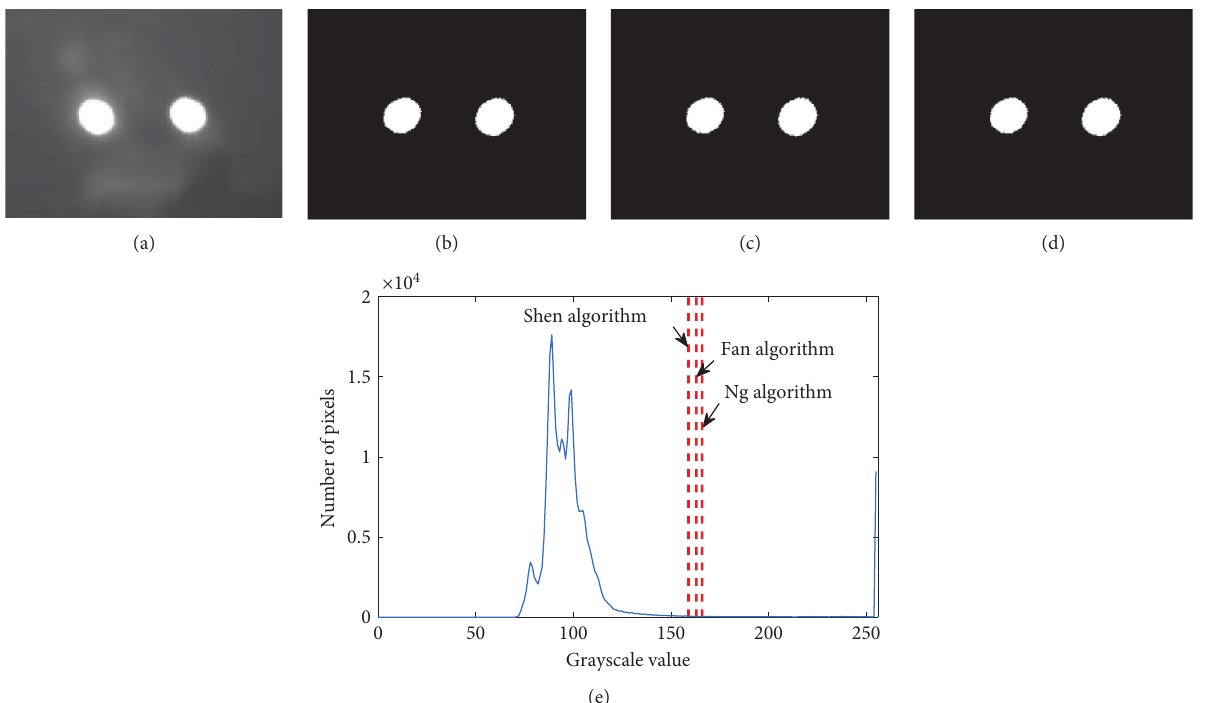
Figure 7: Laser spot segmentation effect without interference: (a) original image, (b) Ng algorithm, (c) Fan algorithm, (d) Shen algorithm, and (e) histogram and each segmentation threshold.